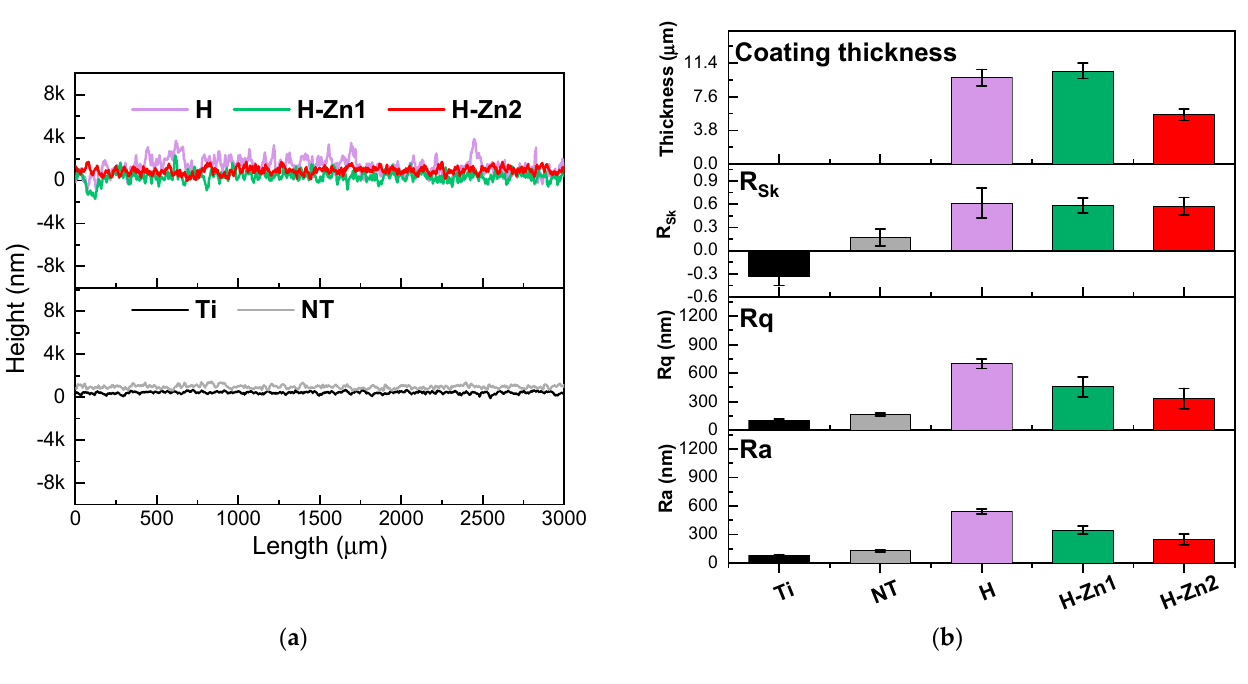
Figure 5. Specific profile lines ( a ) and evolution of the main roughness parameters and coating thickness ( b ) of the investigated material.